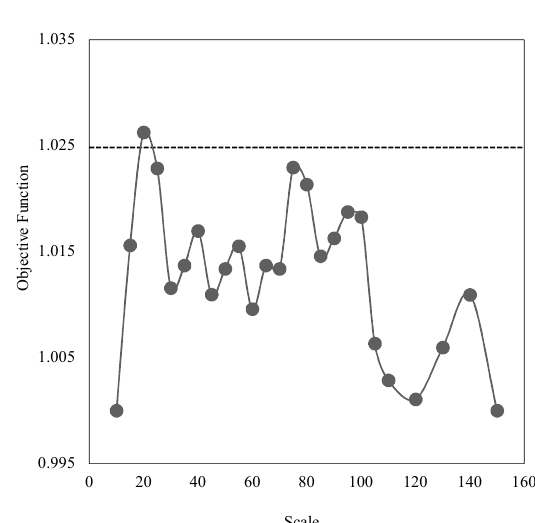
Figure 3. Plot of objective function versus scale with a dotted line showing a